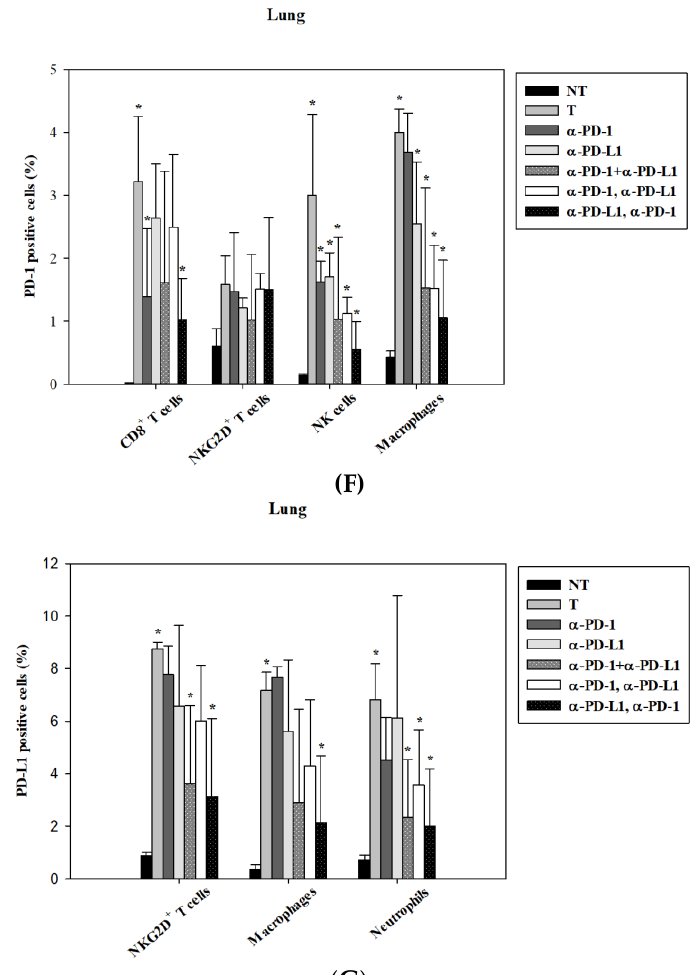
Figure 5. Alterations of local immune cells in a lung metastatic animal model after monotherapy and various combination treatments of anti-PD-1 and anti-PD-L1. ( A ) Dot plots of flow cytometric analysis revealed the alteration of T cells (upper left region in blue) and neutrophils (upper and lower right region in green) on day 17 post-treatment. ( B ) Other immune cells with double negative CD3 and Ly6G (lower left region of A ) were further gated and analyzed to distinguish macrophages / monocytes / DCs (lower right, pink color) and inflammatory monocytes (upper right, dark green color) by Ly6C and CD11b staining. ( C ) The proportion of PD-1-positive cells in CD8 + T cells in response to ICI therapies. ( D ) The proportion of PD-L1 positive cells in NKG2D + T cells in response to ICI treatment. ( E ) Quantification of the immune cell profile in the lung on day 17 post-treatment in lung metastasis mice. ( F ) Quantification of major immune cells expressing PD-1 in lung metastases on day 17 post-treatment. ( G ) Quantification of major immune cells expressing PD-L1 in lung metastases on day 17 post-treatment. The tumor (T) group from lung metastatic mice was compared with the no tumor (NT) group from normal mice. In ICI-treated groups, statistical analysis was performed with the tumor (T) group (* p < 0.05). Total leukocytes (CD45 + ) = 100%. Immune cells were defined as follows: T cells (CD3 + / CD11b − ), CD8 + T cells (CD3 + / CD11b − / CD8 + ), CD4 + T cells (CD3 + / CD11b − / CD4 + ), NKG2D + T cells (CD3 + / CD11b − / NKG2D + ), neutrophils (CD11b + / Ly6G + ), macrophages (CD3 − / CD11b + / Ly6C + / F4 / 80 + ), NK cells (CD3 − / Ly6G − / CD11b − / NKG2D + ). n = 3 for each group.